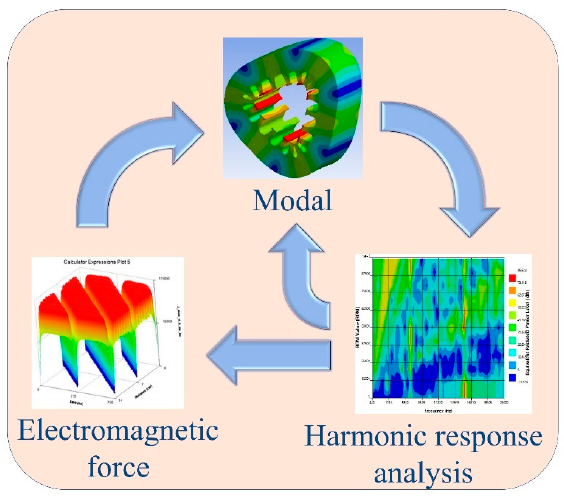
Figure 1. Vibration and noise research process.